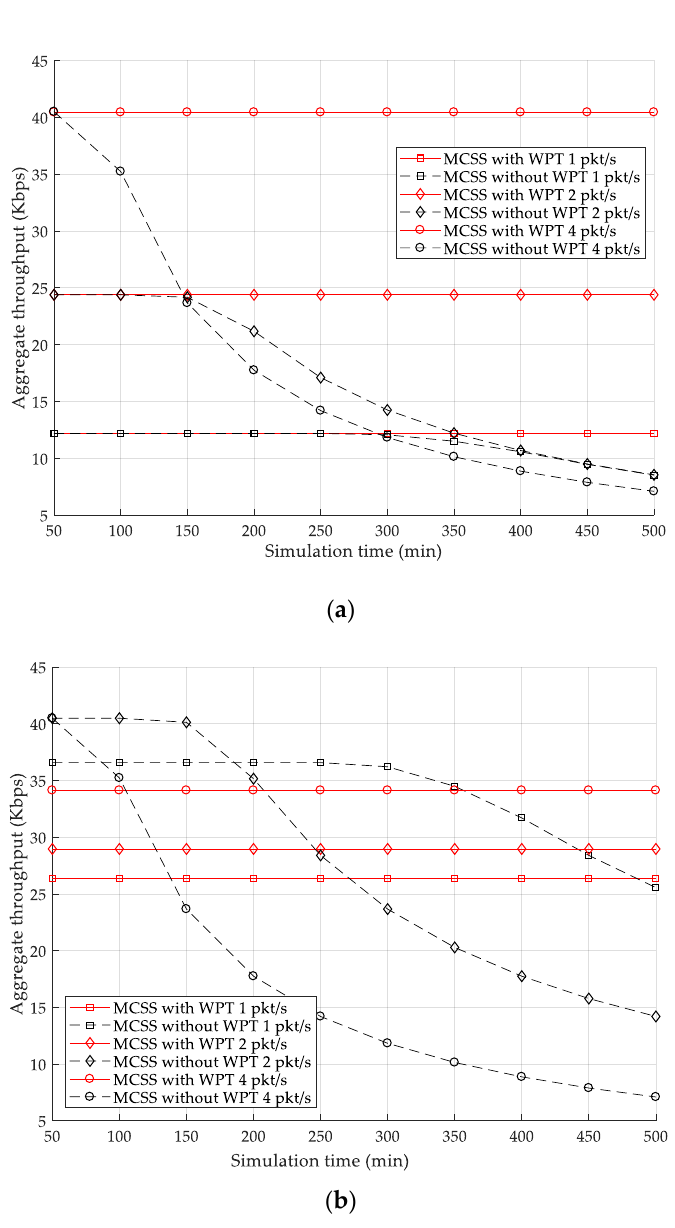
Figure 11. Effect of WPT on aggregate throughput: ( a ) 12 and ( b ) 36 sensor nodes.